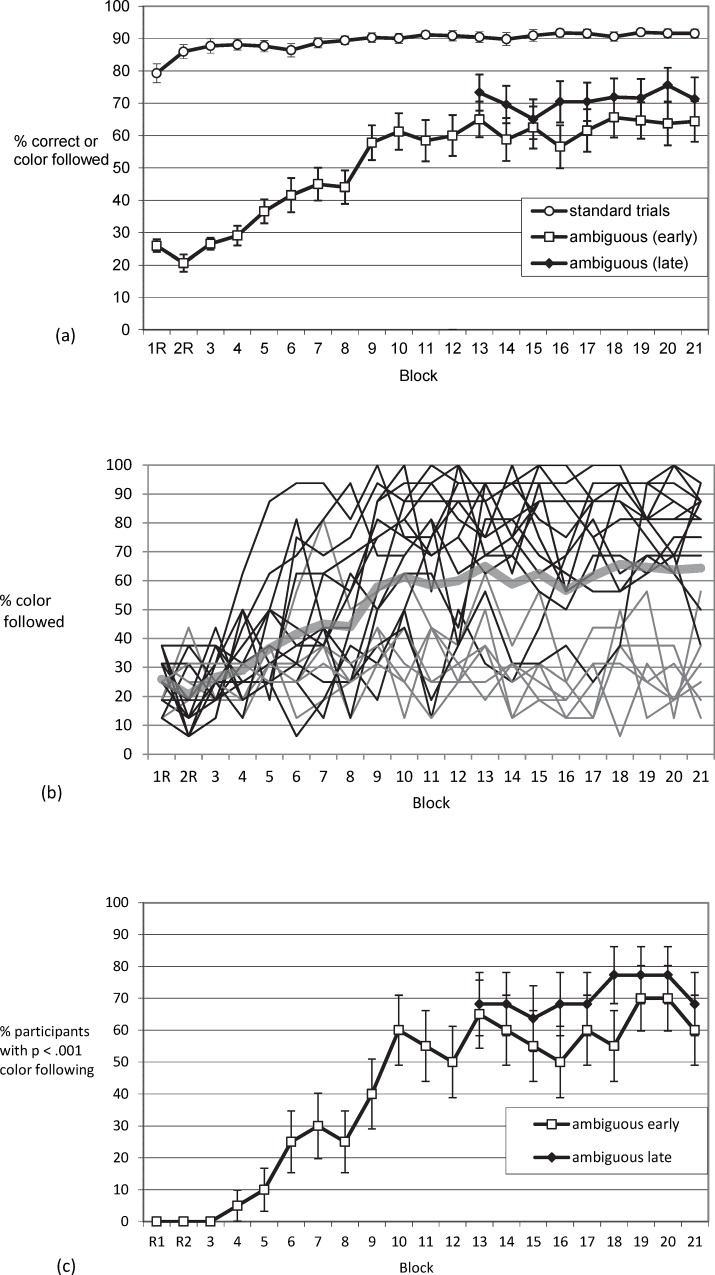
Exp. 1: Color usage in ambiguous trials.Panel (a) shows that the average proportion of ambiguous trials that elicit a response in line with the color-position covariation increases with practice in the ambiguous-throughout condition. The ambiguous-after-learning condition sets in with a similar rate of color usage in ambiguous trials. Panel (b) shows that continuous increases found when averaging across participants are not representative for the dynamics in the individual participant: Some participants show strong increases in color usage (some early in practice, others late in practice), while others never show strong color usage. In line with this, Panel (c) suggests that the average increase of color usage with practice is a mixture phenomenon–being mainly driven by the increasing proportion of participants who at a certain point in practice already show strong color usage. Error bars depict the between subjects standard error of the mean.